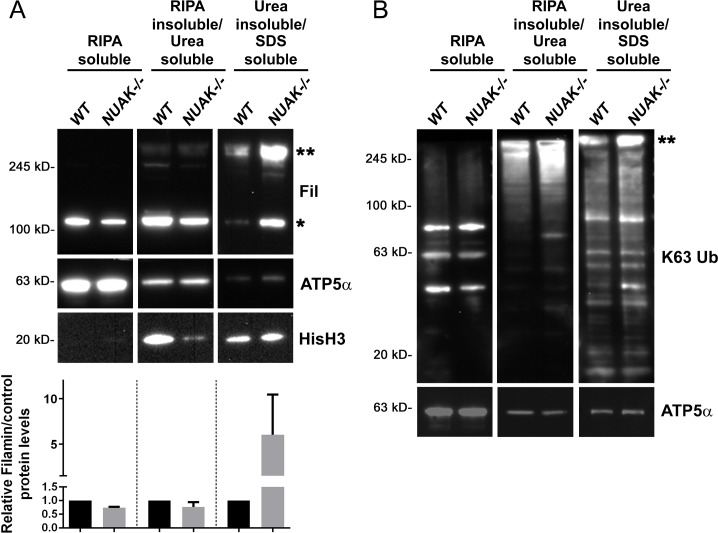
Loss of NUAK results in the insoluble accumulation of Fil and K63-linked Ub.(A,B) Western blots probed for Fil (A) or K63-linked Ub chains (B) after fractionation of WT or NUAK-/- L3 muscle carcasses into soluble or insoluble fractions. (A) Fil protein levels are similar in RIPA or Urea-soluble fractions, but preferentially increased in the pellet (solubilized by SDS, single asterisk). A substantial portion of aggregated Fil protein did not migrate into the gel (double asterisks). Densiometric quantitation of Fil protein levels (single asterisk) reveals ~5-fold increase in Fil protein levels upon loss of NUAK. (B) Poly-Ub chains that contain K63 linkages broadly accumulate in the insoluble fractions of NUAK-/-. Similar to Fil, a portion of K63-linked proteins accumulate in the top of the SDS-PAGE gel (double asterisk). The loading control ATP5α is largely soluble, but also present in Urea and SDS-soluble fractions. HisH3 was used to confirm insoluble loading.